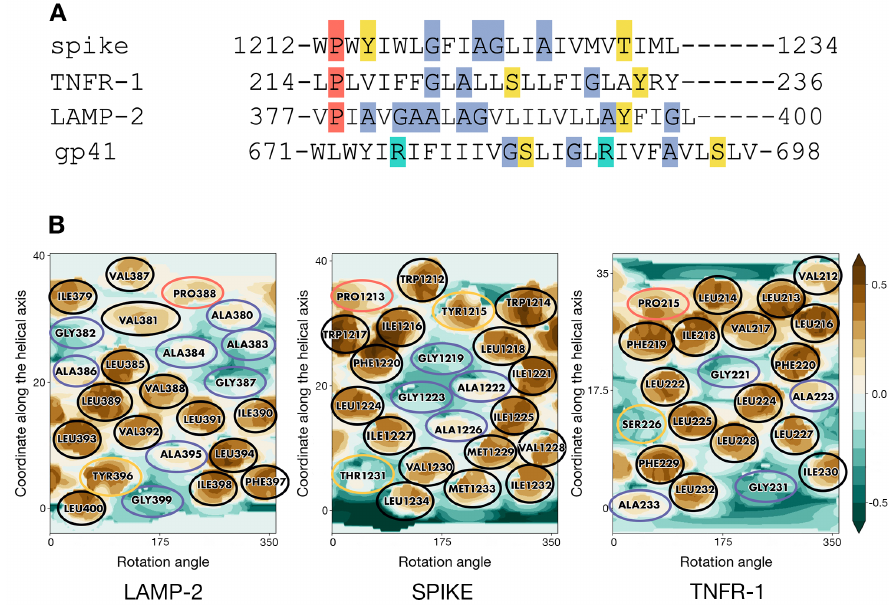
Figure 2. Residue patterns in S-TMD and candidate templates. ( A ) The similarity between patterns in the sequences of spike glycoprotein and TMDs with known 3D structure-LAMP-2 (2MOM), TNFR-1 (7K7A), and gp41 (5JYN). Hydrophobic residues are unhighlighted, while proline, small, charged, and polar residues are highlighted in coral, blue, turquoise, and yellow, respectively. ( B ) Molecular hydrophobicity potential (MHP) distribution maps for an ideal helix corresponding to S-protein residues 1212–1234 and TMD monomers of two candidate templates, LAMP-2 and TNFR-1. Cylindrical projection of the surface MHP distribution is used. Axis values correspond to the rotation angle around the helical axis and the coordinate along the latter (in Å), respectively. An MHP